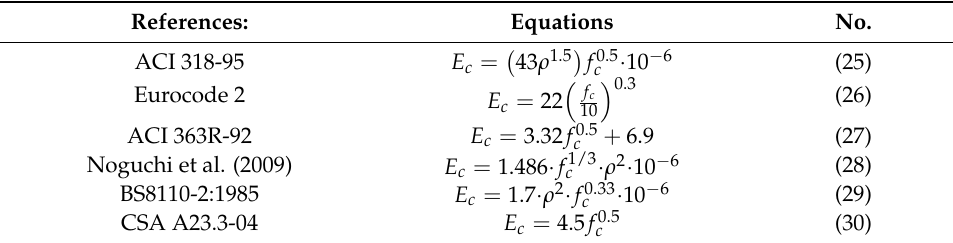
Table 6. Relationship between the static modulus of elasticity and compressive strength, adapted from Jurowski et al. [49].